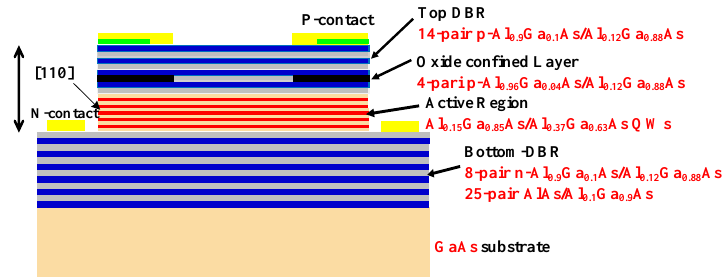
Figure 8. Schematic cross-section of InGaAs 850 nm VCSEL structure .